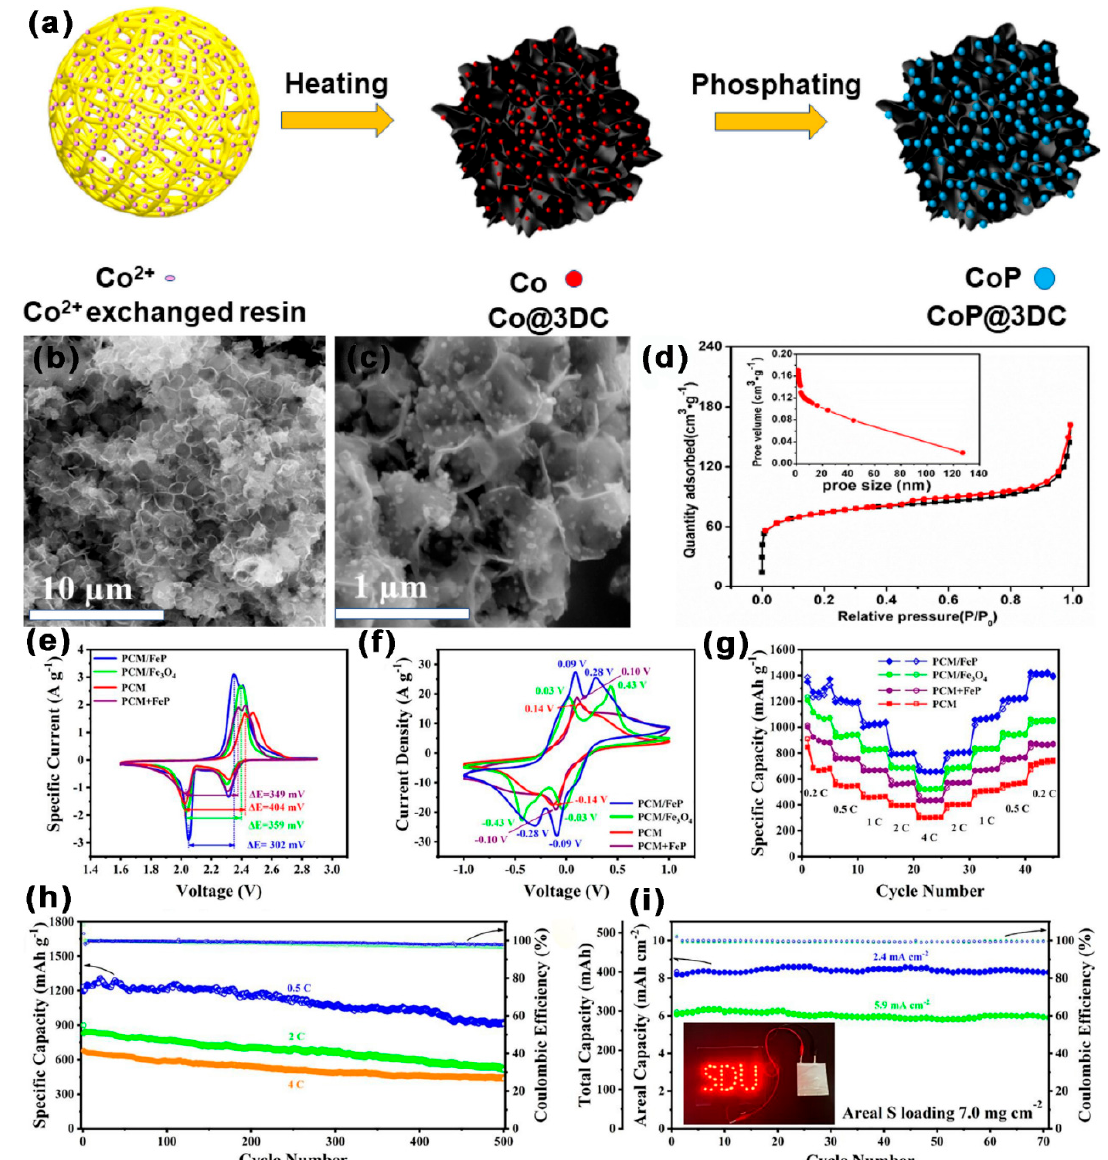
Figure 18. ( a ) Schematic diagram of the preparation of CoP@3DSC, ( b , c ) SEM images, ( d ) N 2 adsorp- tion/desorption isotherms of CoP@3DSC [116] (The upper curve represents the desorption isotherm, while the lower curve represents the adsorption isotherm). ( e ) CV pro fi les of LSBs with PCM/FeP/S cathode. ( f ) CV pro fi les of symmetric ba tt eries. ( g ) Rating performance of LSBs with PCM/FeP/S cathode (0.2 C–4 C). ( h ) Long cycle of LSBs with PCM/FeP/S cathode. ( i ) Long cycle of pouch cell with PCM/FeP/S cathode (the inset shows an optical picture of a pouch cell in operation) [117]. 3C etc. is indicated above the solid line in ( h ) and 2.4 mA cm − 2 etc. is marked above the dashed line in ( i ).